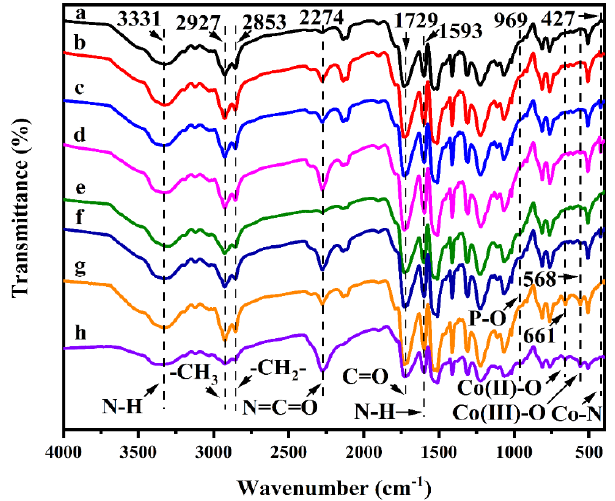
Figure 6. FT-IR spectra of all RPUFs ( a ): neat RPUF, ( b ): RPUF-MOF/MWCNT 1, ( c ): RPUF- MOF/MWCNT 2, ( d ): RPUF-MOF/MWCNT 3, ( e ): RPUF-T, ( f ): RPUF-T-MOF/MWCNT 2, ( g ): RPUF-C-MOF/MWCNT 2, ( h ): RPUF-T/C-MOF/MWCNT 2.